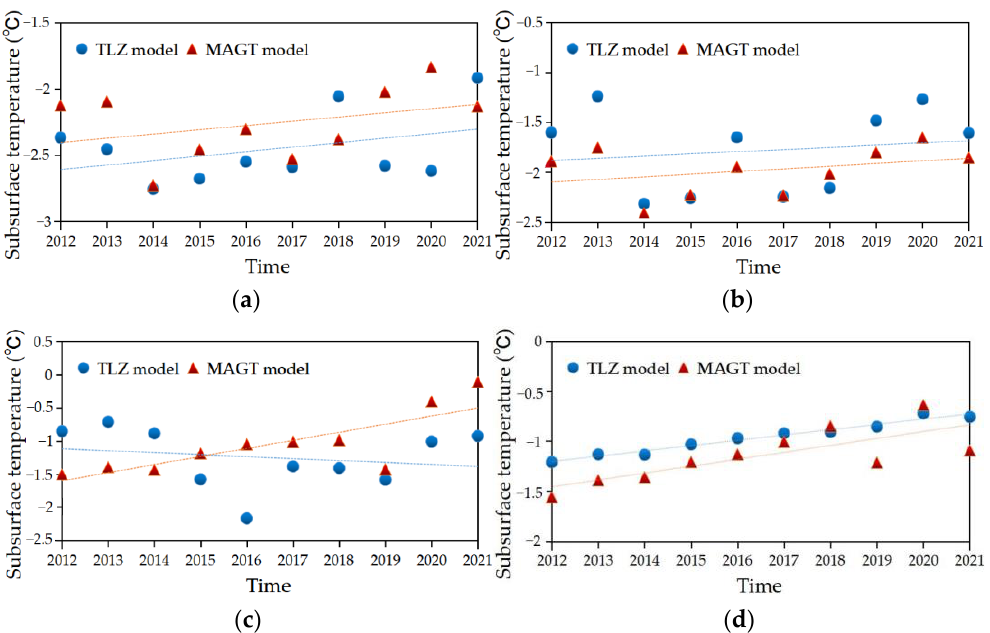
Figure 15. Daily mean subsurface temperatures among 27 CMDC stations at 30, 50, 60, and 300 cm depths for the period from 2012 to 2021.